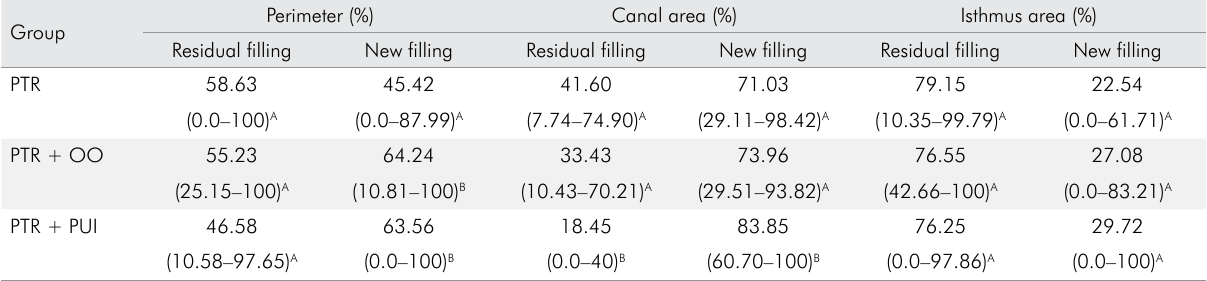
Table. Median, maximum and minimum values of residual and new filling, in percentage, for perimeter, canal area, and isthmus area